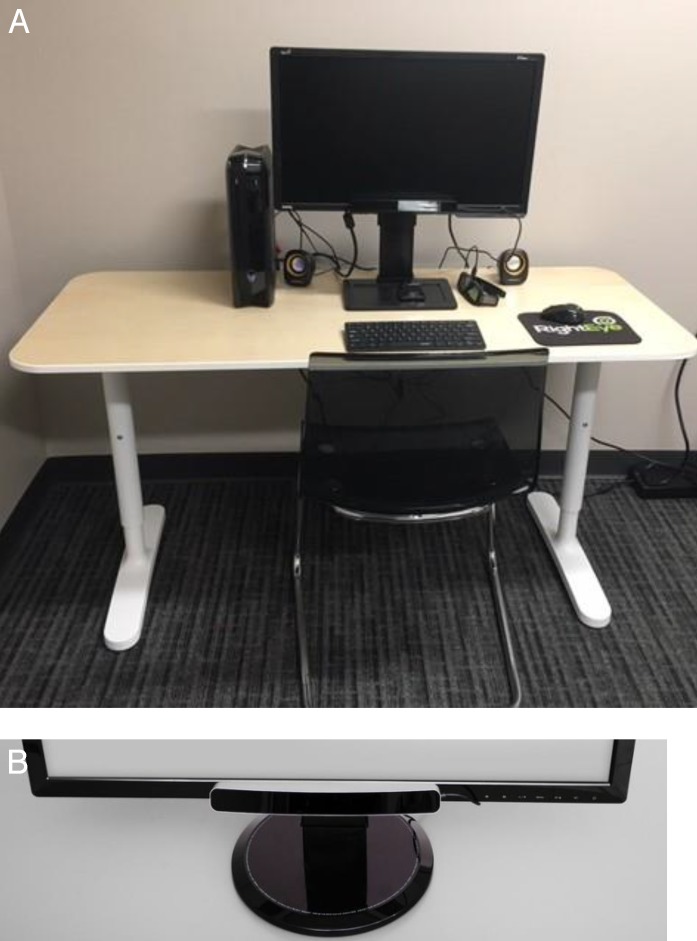
(A) RightEye set up. (B) Magnification of eye tracker.